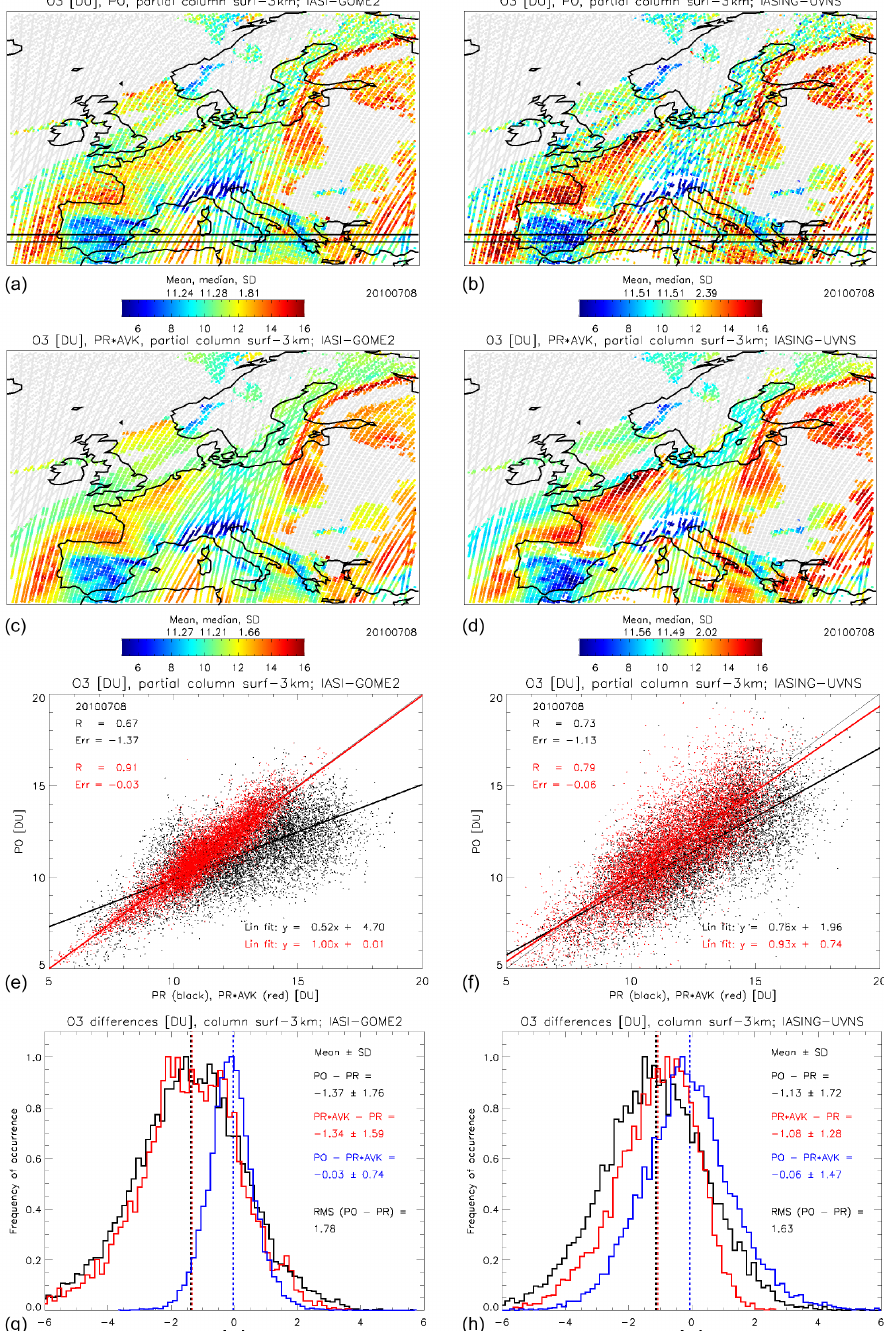
Figure 5. IASI + GOME-2 (a, c, e, g) and IASI-NG + UVNS (b, d, f, h) data, for 8 July 2010. (a, b) Maps of O3-3km [DU] from pseudo- observations (POs), grey colour indicates where CLF is larger than 0.3. Black lines indicate the [38, 39 ◦ N] latitude band. (c, d) Maps of O3-3km [DU] from AVK-smoothed pseudo-reality (PR × AVK). (e, f) Scatter plot of O3-3km [DU] from pseudo-observations ( y axis) versus pseudo-reality (black, x axis) and AVK-smoothed pseudo-reality (red, y axis). Linear correlation coefficient, mean error and linear fit equation are reported in the figure. (g, h) Histograms of normalized frequency distribution of O3-3km differences [DU] between POs and PR (black), PR × AVK and PR (red), PO and PR × AVK (blue). Mean value and standard deviation of each difference is reported in the figure, together with PO–PR root mean square